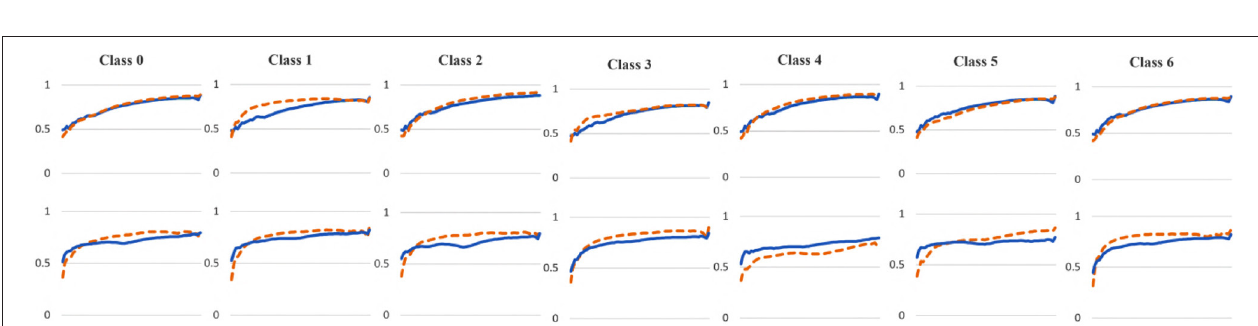
FIGURE 8 | Comparison of the Cut Position (Layer) VS SSIM cut curve for the ResNet-50, ResNet-50-10 % , 2-Conv-ResNet, and 2-Conv-ResNet-10% models, and Cut Value Difference for the ResNet-50, ResNet-50-10 % for different datasets. The value in the legend of the chart indicate the training and testing accuracy of the model. (A) Weedling. (B) Plant village.